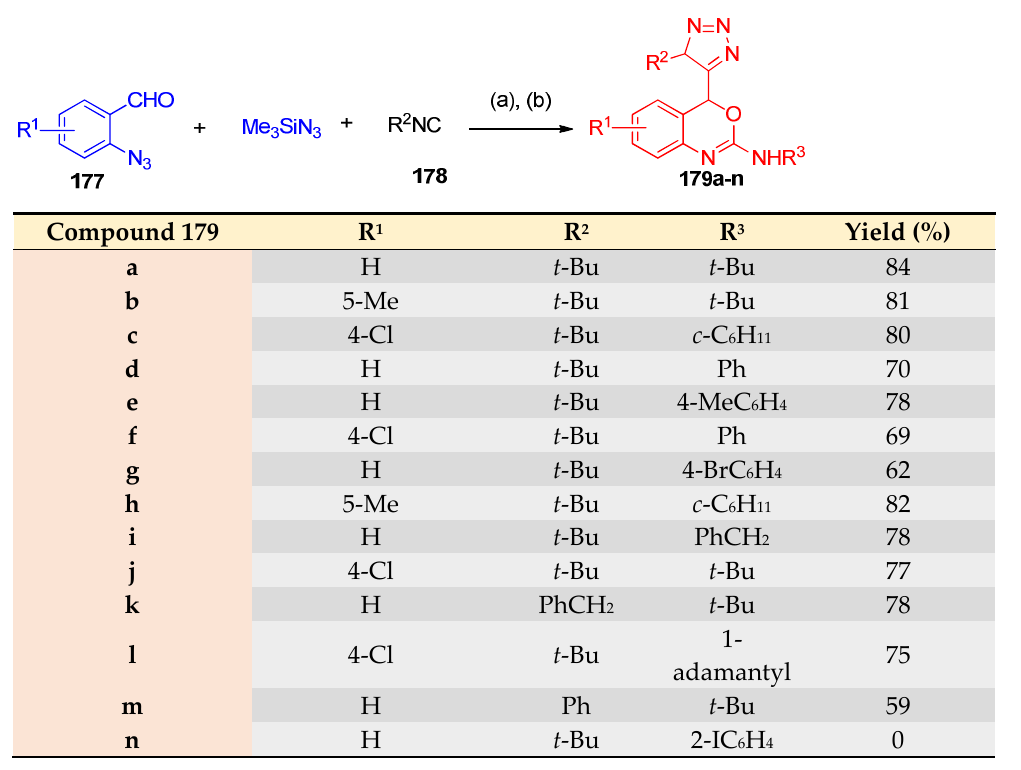
Scheme 68. Synthesis of 4-triazolylbenzoxazoline derivatives. Reagents and conditions : (a) CH 2 Cl 2 ; (b) R 3 NC 178 , Pd(PPh 3 ) 4 , THF, 60 °C.